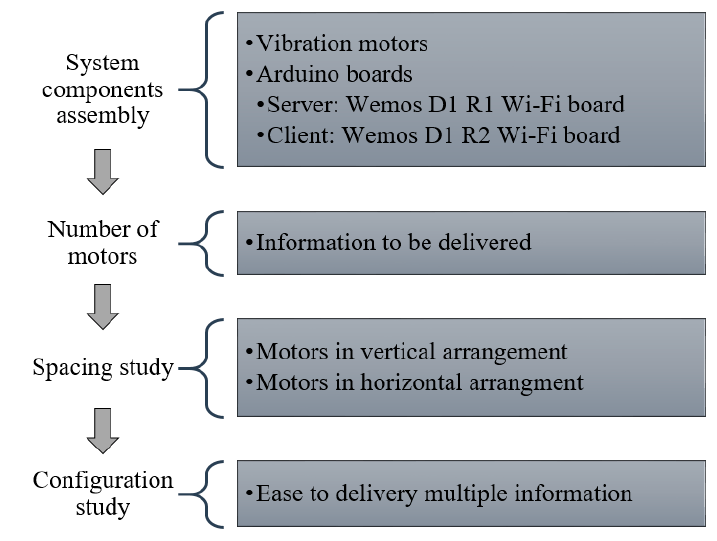
Figure 1. General approach.